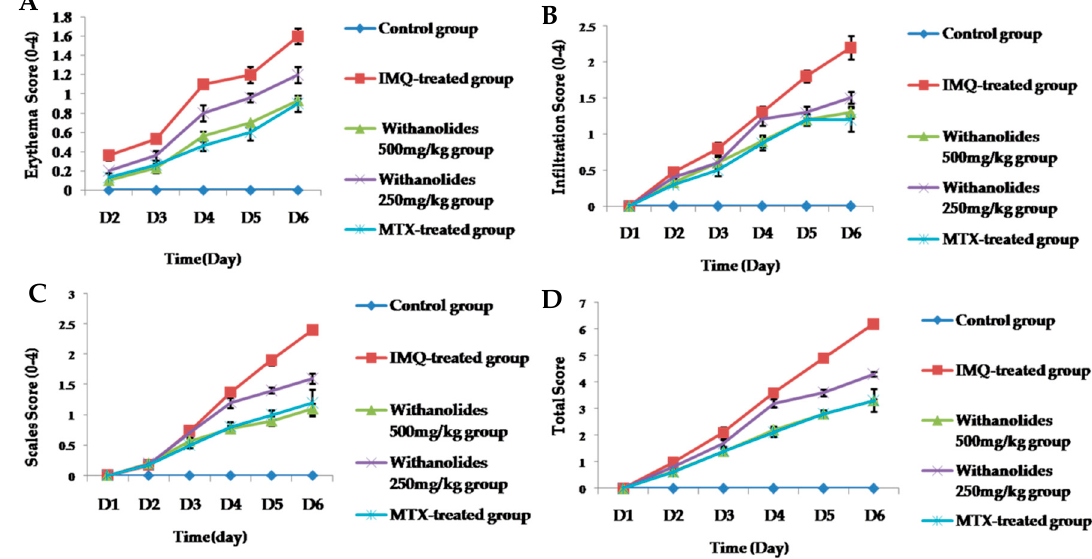
Figure 2. ( A – D ) The back skin of the five groups showed di ff erent grades of erythema, scales, infiltration Figure 2. ( A – D ). The back skin of the five groups showed different grades of erythema, scales, and total infiltration and total score.